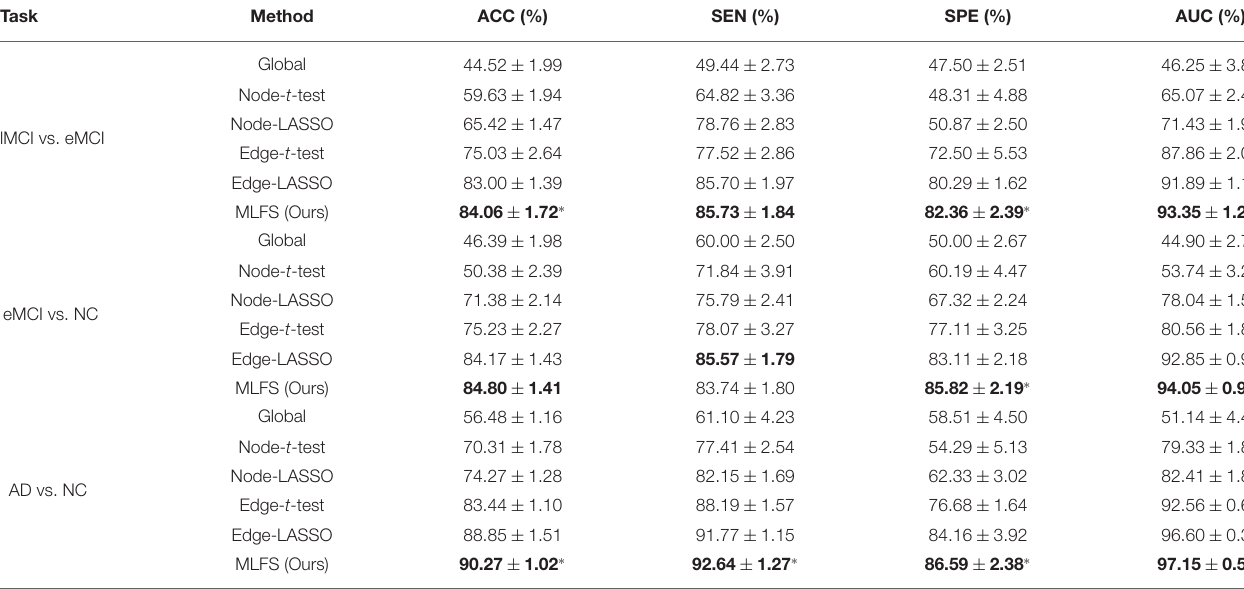
TABLE 2 | Classification performance of six schemes in three classification tasks (mean ± standard deviation).